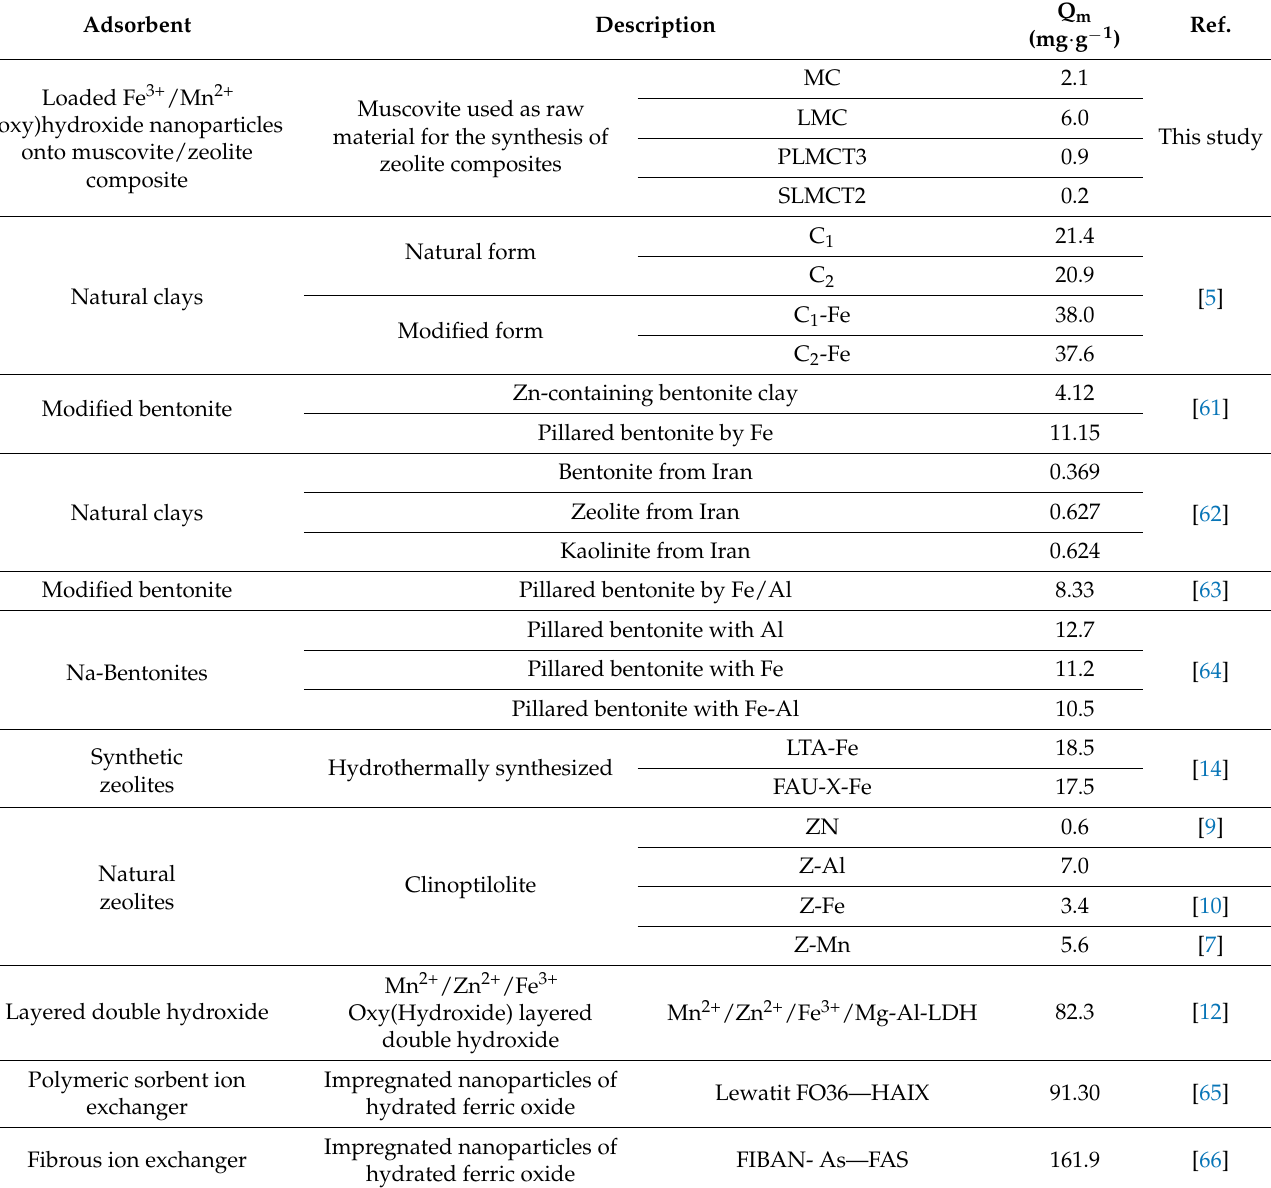
Table 7. Summary of phosphate adsorption capacities of inorganic